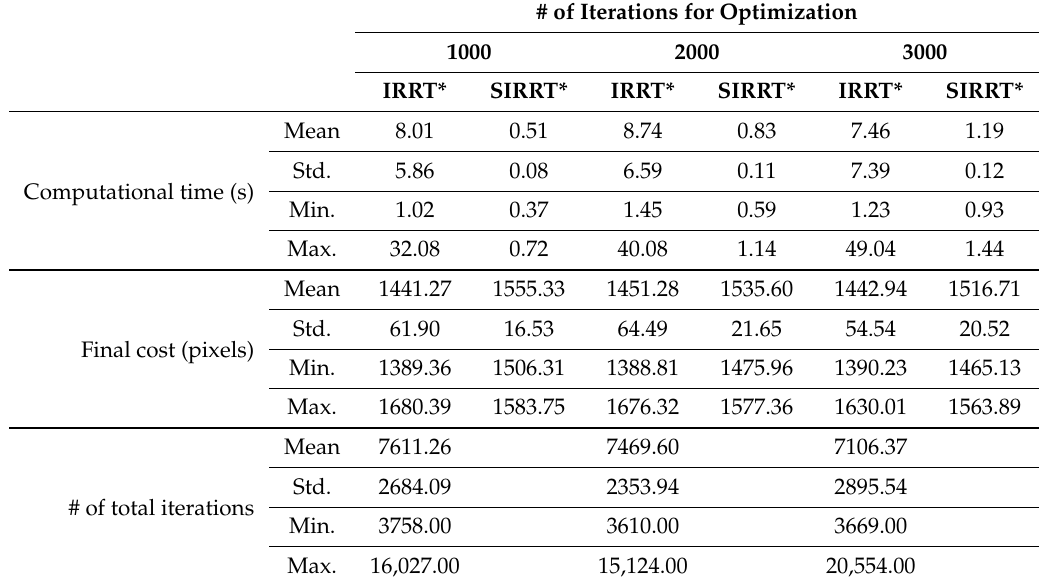
Table 1. A comparison of the IRRT* and the SIRRT*. # of Iterations for